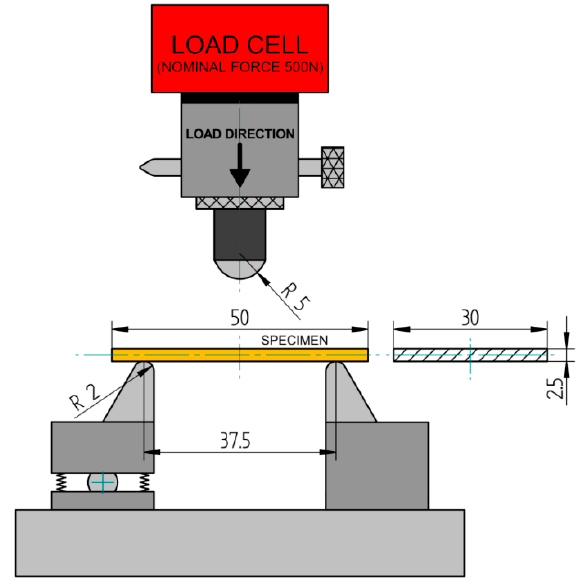
Figure 4. Test system used in the three-point bending test according to ISO 178.